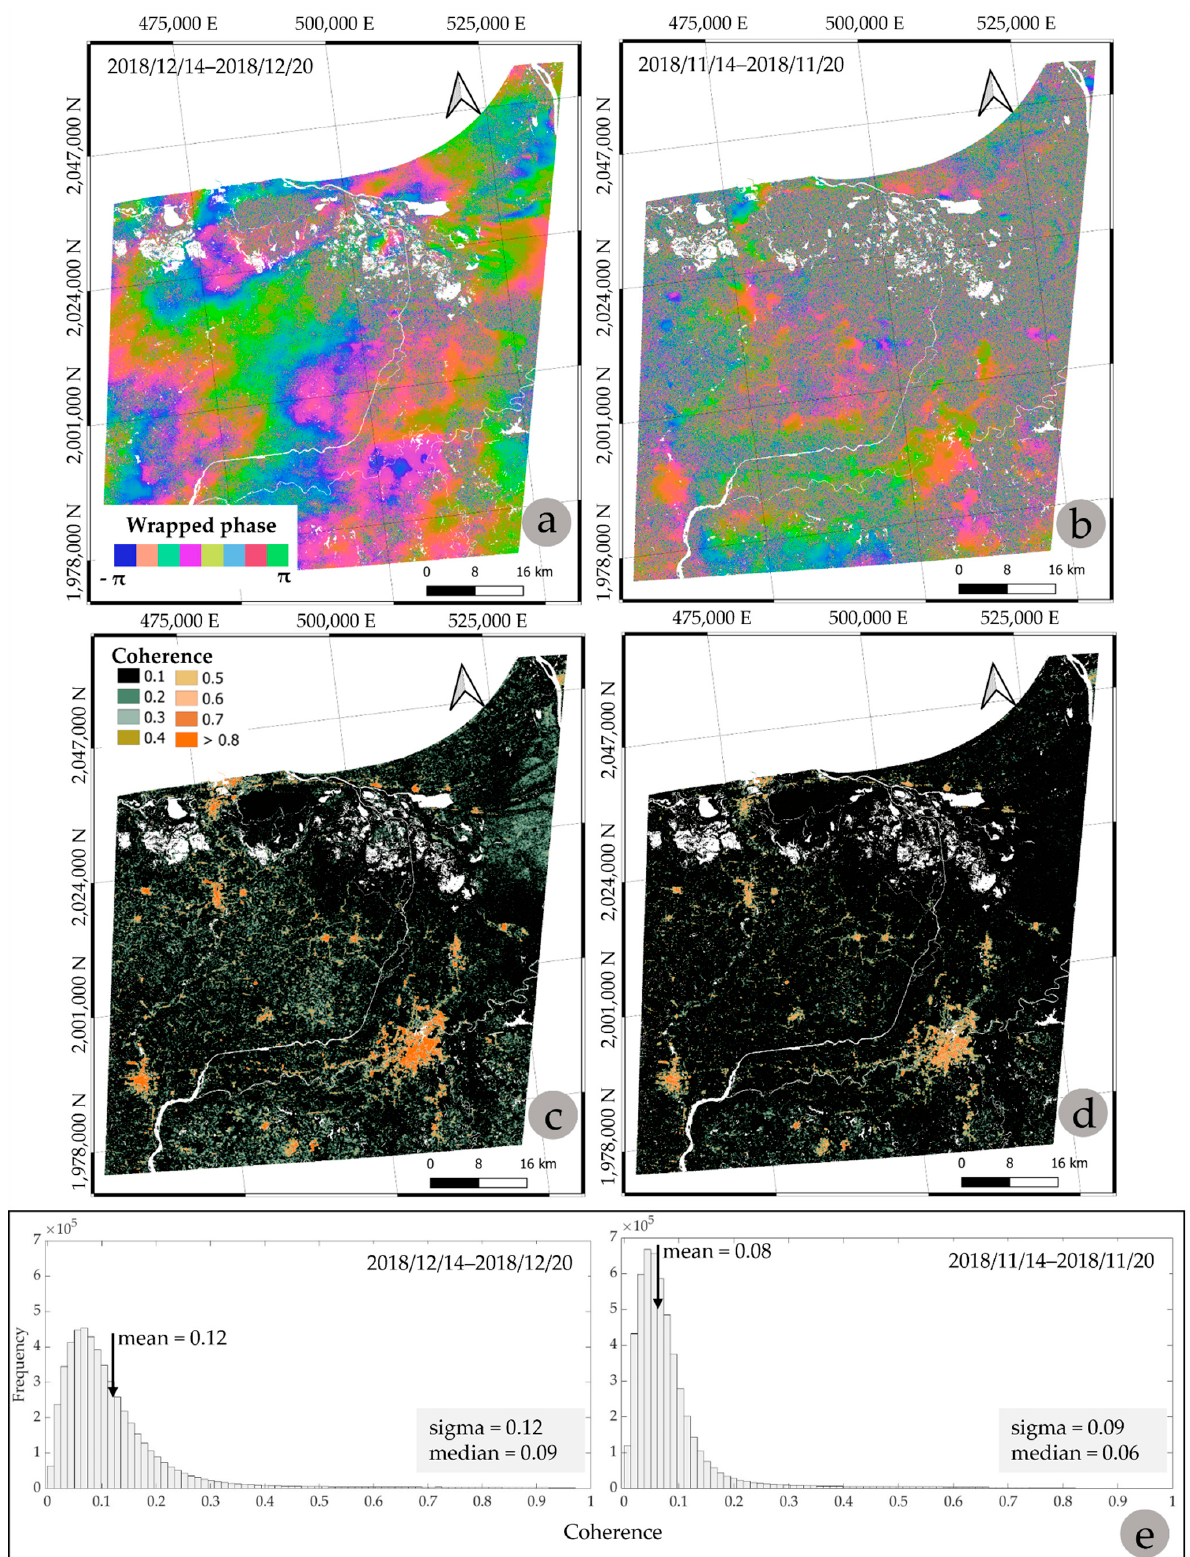
Figure 9. Wrapped differential interferograms: ( a ) 14 December 2018 − 20 December 2018 and ( b ) 14 November 2018 − 20 November 2018; their respective coherence images ( c , d ), and histograms ( e ).